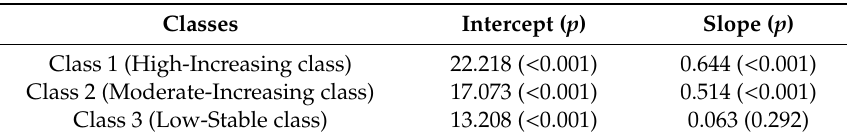
Table 4. Intercept and slope of each